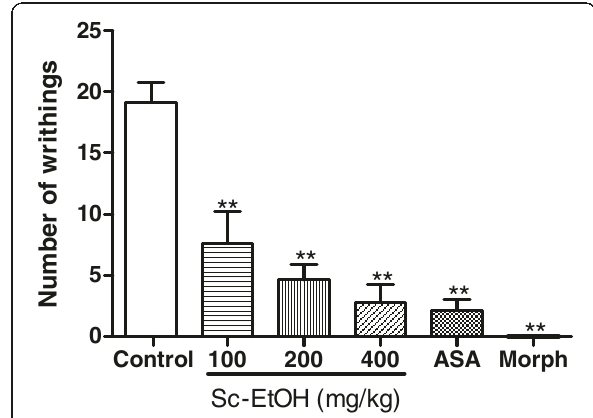
Figure 3 Effect of ethanolic extract of Selaginella convoluta (Sc-EtOH), acetylsalicylic acid (ASA 150 mg/kg) and morphine (Morph 10 mg/kg) on formalin test (first phase). Values are mean ± S.E.M.; **p < 0.01, significantly different from control; ANOVA followed Dunnett ’ s test (n = 6, per group).